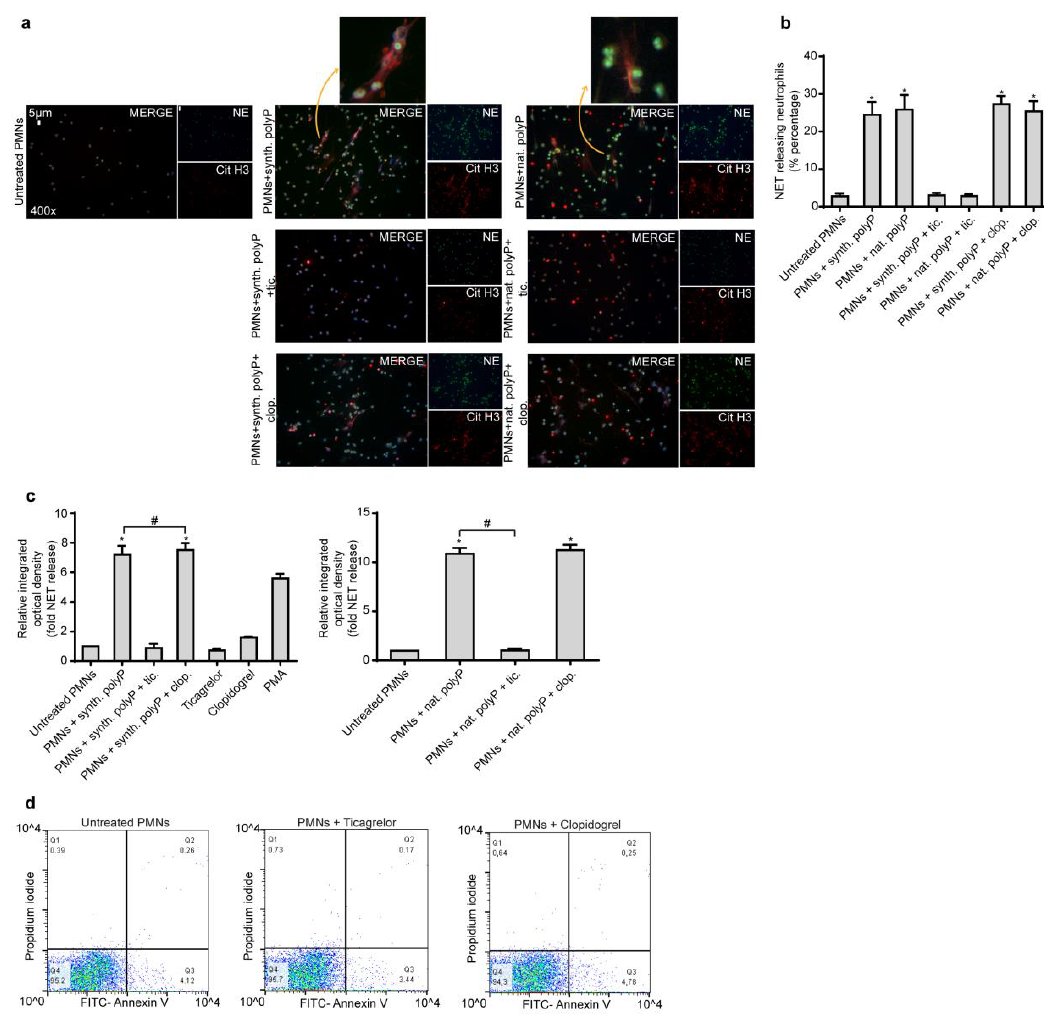
Figure 1. Ticagrelor inhibits NET release induced by polyP in vitro. ( a ). Fluorescence microscopy for cit-H3 / NE staining in control neutrophils treated with synthetic or platelet-derived (natural) polyP, with or without pre-treatment with Ticagrelor or Clopidogrel. One representative out of six independent experiments is shown. Original magnification: 400 × , Scale bar: 5 µ m. Blue: DAPI, Green: NE, Red: cit-H3. ( b ). Percentage of NET-releasing neutrophils as assessed by immunofluorescence. ( c ). MPO-DNA complex levels in NET structures from these stimulations, as assessed by ELISA. Relative integrated optical density was calculated compared to control NETs value. Data from six independent experiments presented as mean ± SD. Statistical significance *, # p < 0.05. All conditions were compared to untreated / control condition and statistical significance is indicated by the symbol “*”. Any further statistical significance of other comparisons is indicated by the symbol “#”. ( d ). Annexin V / Propidium Iodide flow cytometry of control neutrophils in the presence or absence of Ticagrelor / Clopidogrel. One representative out of six independent experiments is shown. Polymorphonuclear neutrophils